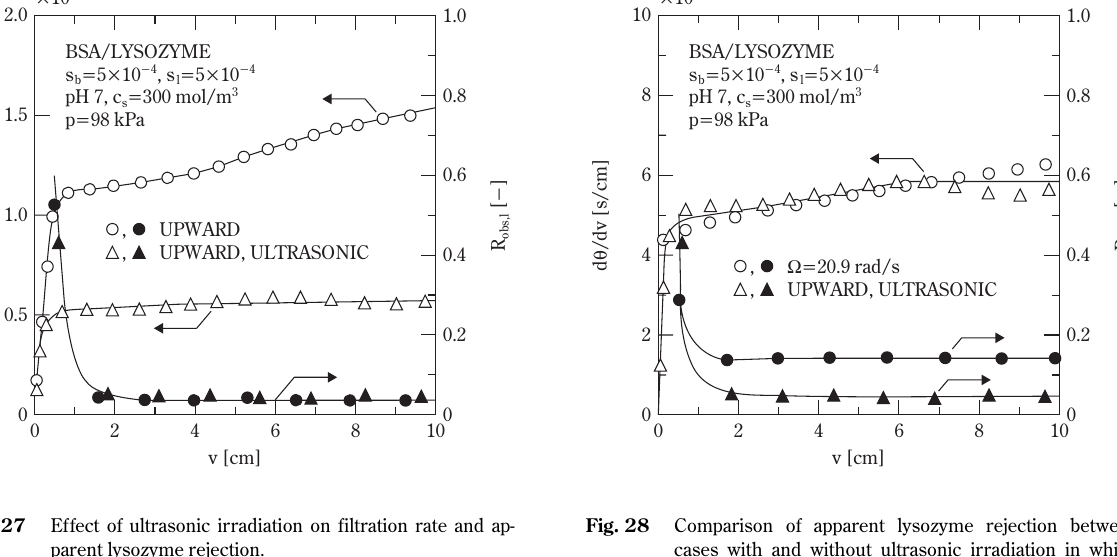
Fig. 27 Effect of ultrasonic irradiation on filtration rate and ap- parent lysozyme rejection.